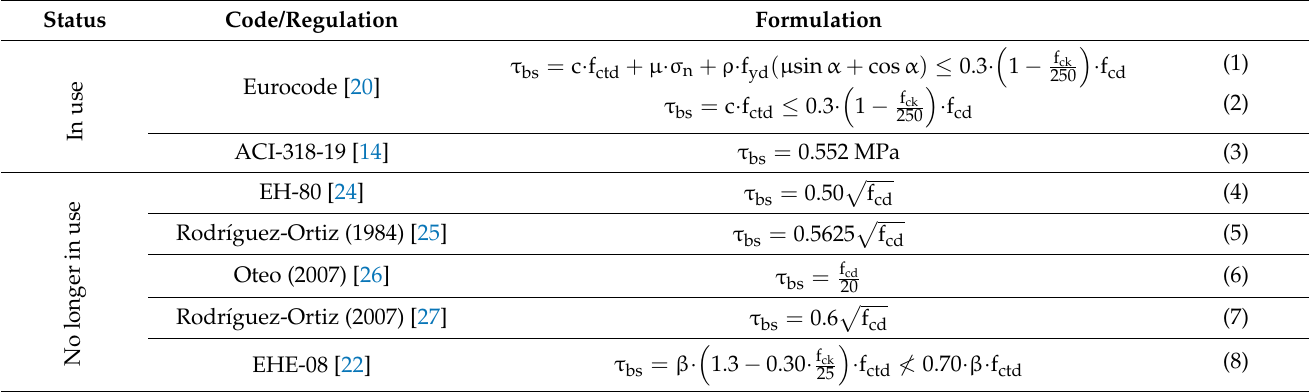
Table 1. Bond stress prediction according to several codes and